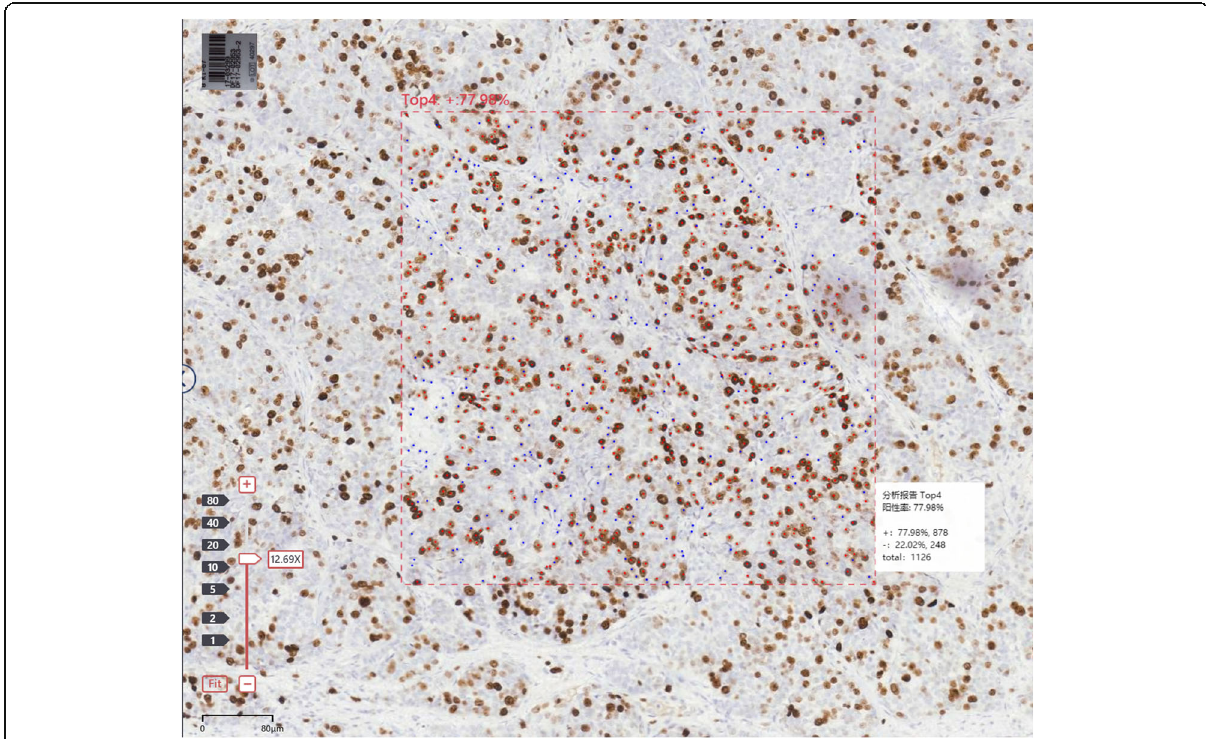
Fig. 4 The automatic analysis function of AI software. It can identify positively stained nuclei and negatively stained nuclei, so as to automatically evaluate the expression level of